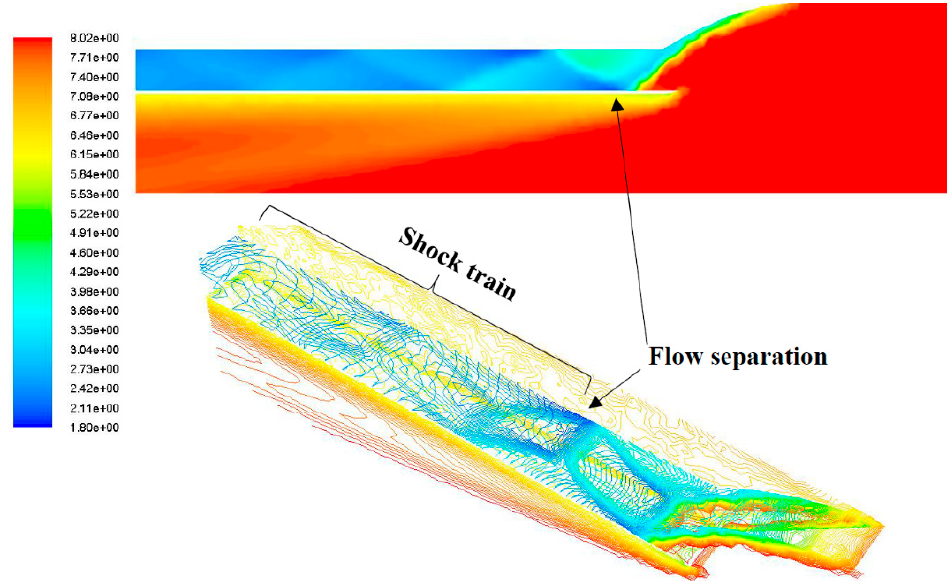
Figure 32. Computational Fluid Dynamics (CFD) results for 3-D inlet simulation at Mach 8.